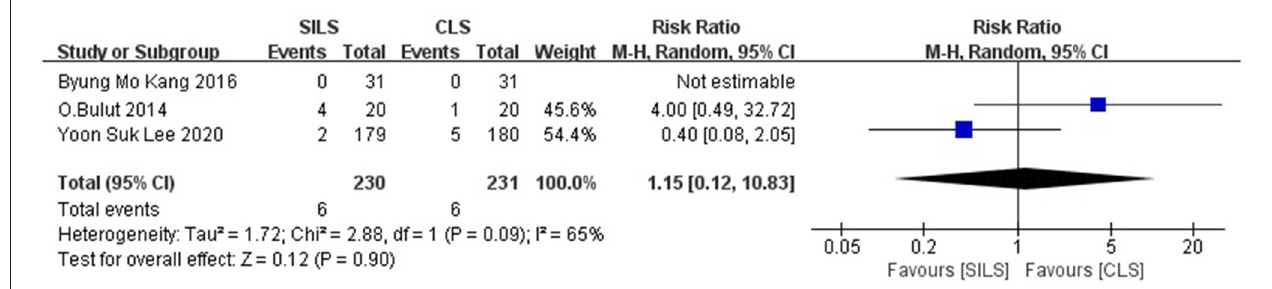
FIGURE 11 | Meta-analysis of readmission. SILS, single-incision laparoscopic surgery; CLS, conventional laparoscopic surgery.